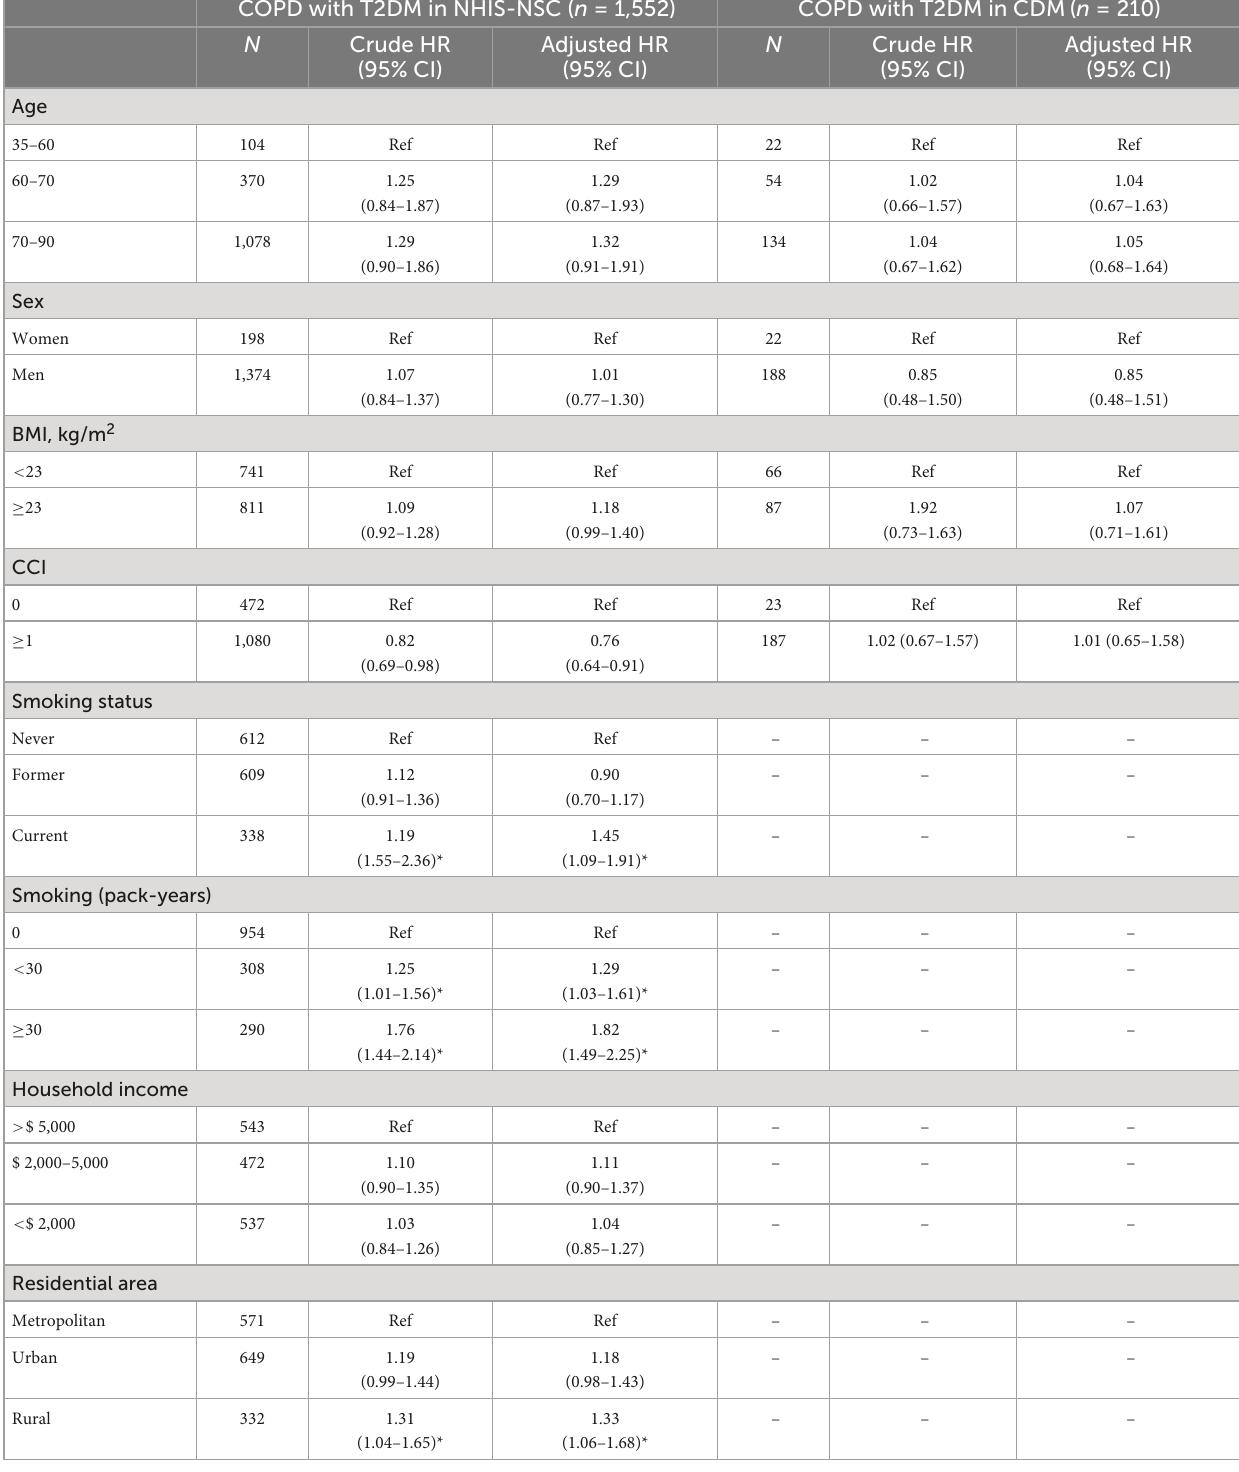
TABLE 2 Subgroup analysis: the risk of lung cancer in COPD patients with T2DM. COPD with T2DM in NHIS-NSC ( n = 1,552) COPD with T2DM in CDM ( n =